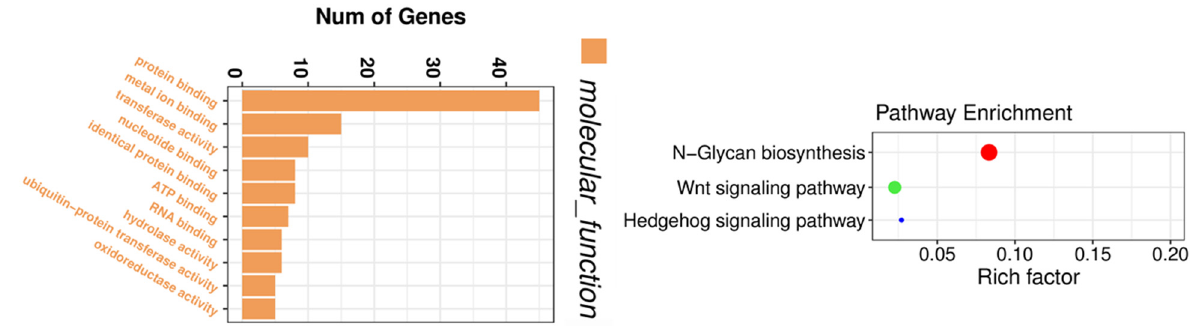
Figure 5. Gene enrichment analysis on circRNAs altered by thymoquinone. The altered circRNAs were associated with the binding of proteins, metal ions, nucleotide, ATP, and RNAs, and correlated with Wnt and Hedgehog signaling pathways.